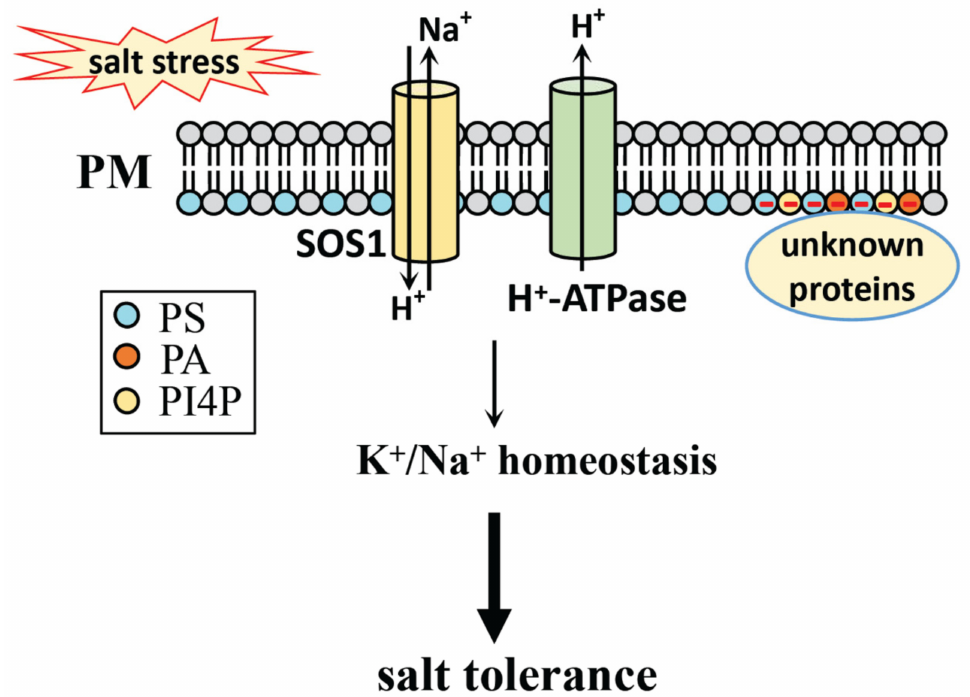
Figure 5. The regulatory role of PS in the salt stress response of plants. PS level is induced by salt stress. PS regulates K + /Na + homeostasis by regulating PM H + -ATPase activity and SOS1 activity under salt stress. PS, together with PI4P and PA, regualtes the electronegative features of plasma membrane in plants, which may participate in salt stress response through the unknown proteins not identified yet. PS, phosphatidylserine; PA, phosphatidic acid; PI4P, PI 4-phosphate; PM, plasma membrane; SOS, salt overly